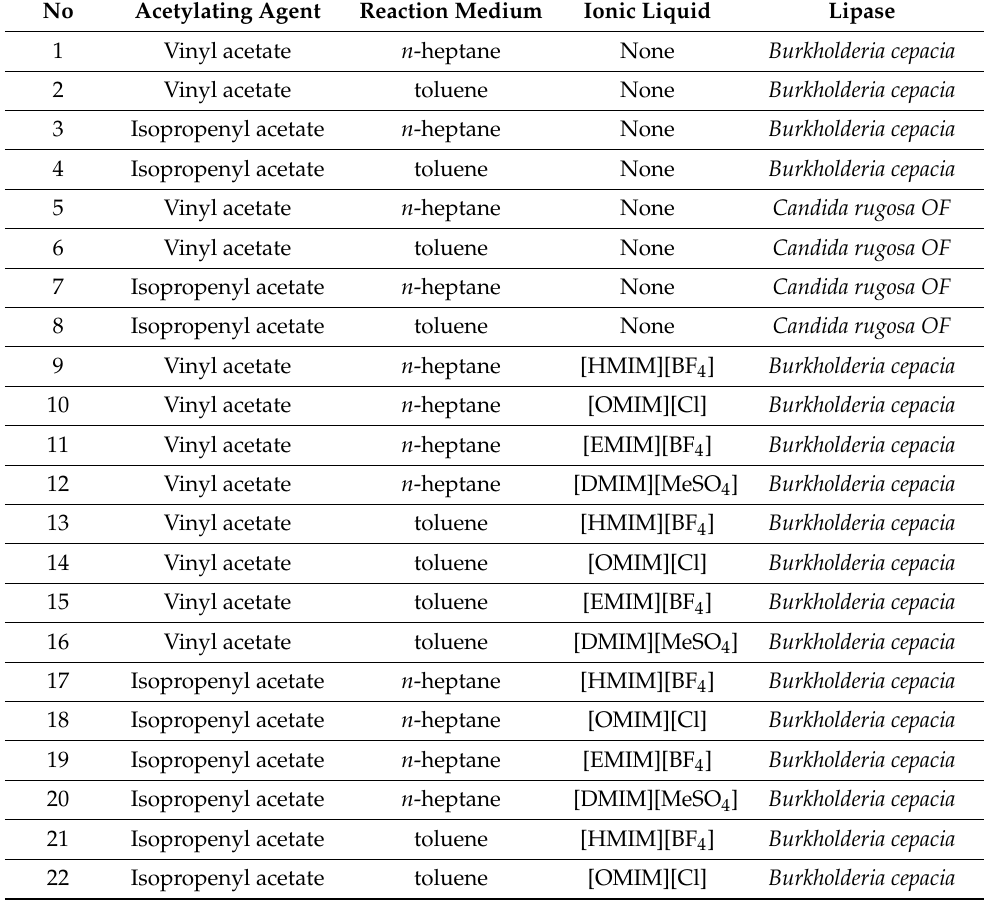
Table 1. List of catalytic systems tested in kinetic resolution of racemic 1-phenylethanol. No Acetylating Agent Reaction